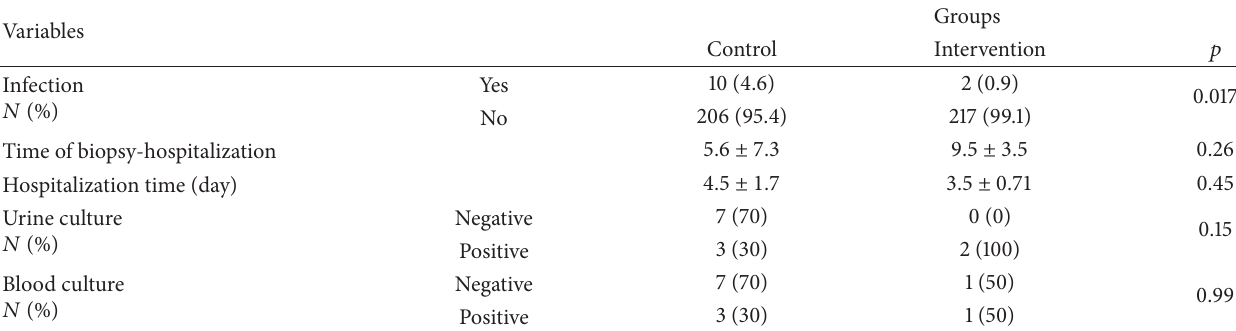
Table 2: Frequency distribution of the infection and the related symptoms of the two groups shown